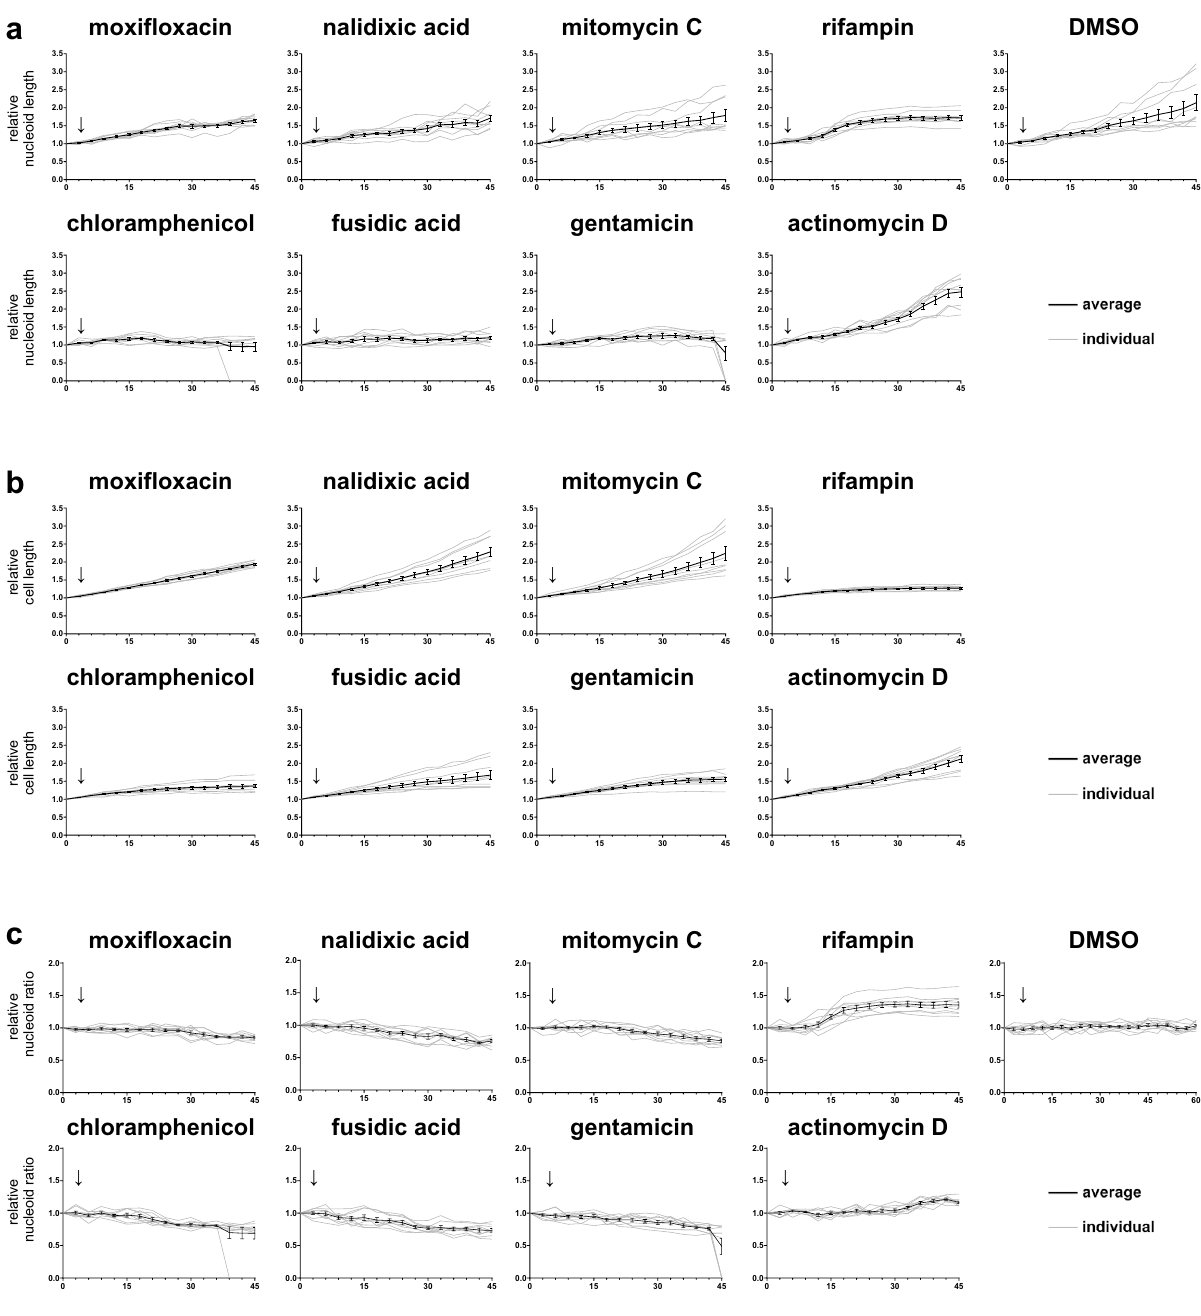
Figure 5. DBMI of cells treated with antimicrobials from the DNA, RNA and protein classes. B. subtilis cells were treated with antimicrobials (2.5 × MIC) as indicated or 1% DMSO (control). Cells were stained with FM4-64 (red, cell membrane) and SYTO-9 (green, nucleoid), and imaged by time lapse confocal fluorescence microscopy with 3 min intervals. Cell morphology data were analyzed from biological triplicate imaging series in triplicate, hence from 9 cells in total per antimicrobial and processed as described in the legend to Fig. 4. Relative nucleoid length, i.e. the length of the nucleoids relative to the length of the nucleoids at t = 0 min, is shown in ( a ) and relative cell length in ( b ) with the ratio of nucleoid length and cell length in ( c ). In case nucleoid fluorescence was not detectable, the nucleoid length was recorded as 0 µm. The mean of antimicrobial- treated cells was plotted in black with error bars representing the SEM. Gray lines represent individual antimicrobial-treated cells on which the mean was based. Relative cell length DMSO control is depicted in Fig. 4c. The timepoint at which antibiotic was added is indicated with a vertical